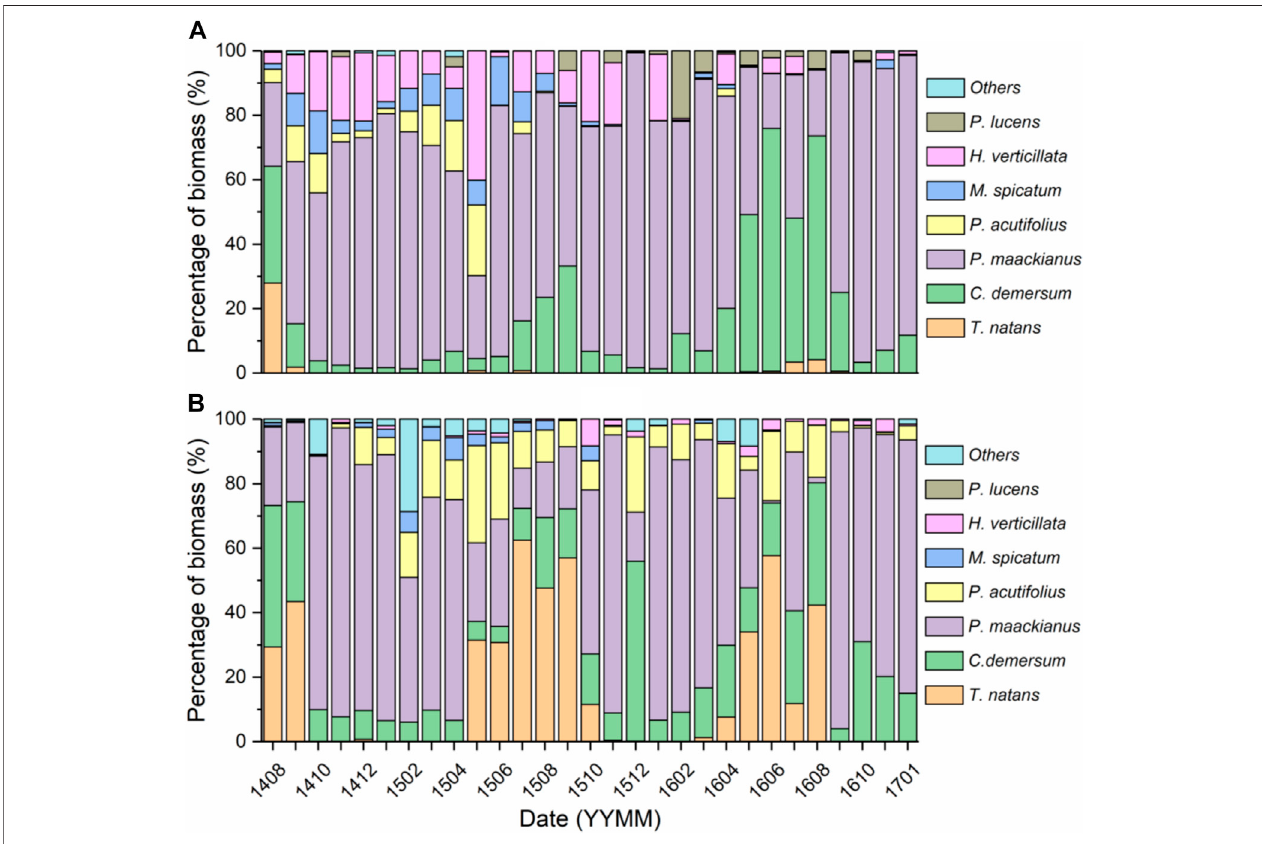
FIGURE5 | Proportion ofbiomass ofeach species inaquatic plant community of twozones ( (A) for non- Trapa zone, (B) for Trapa zone, number ofreplicates: 12).